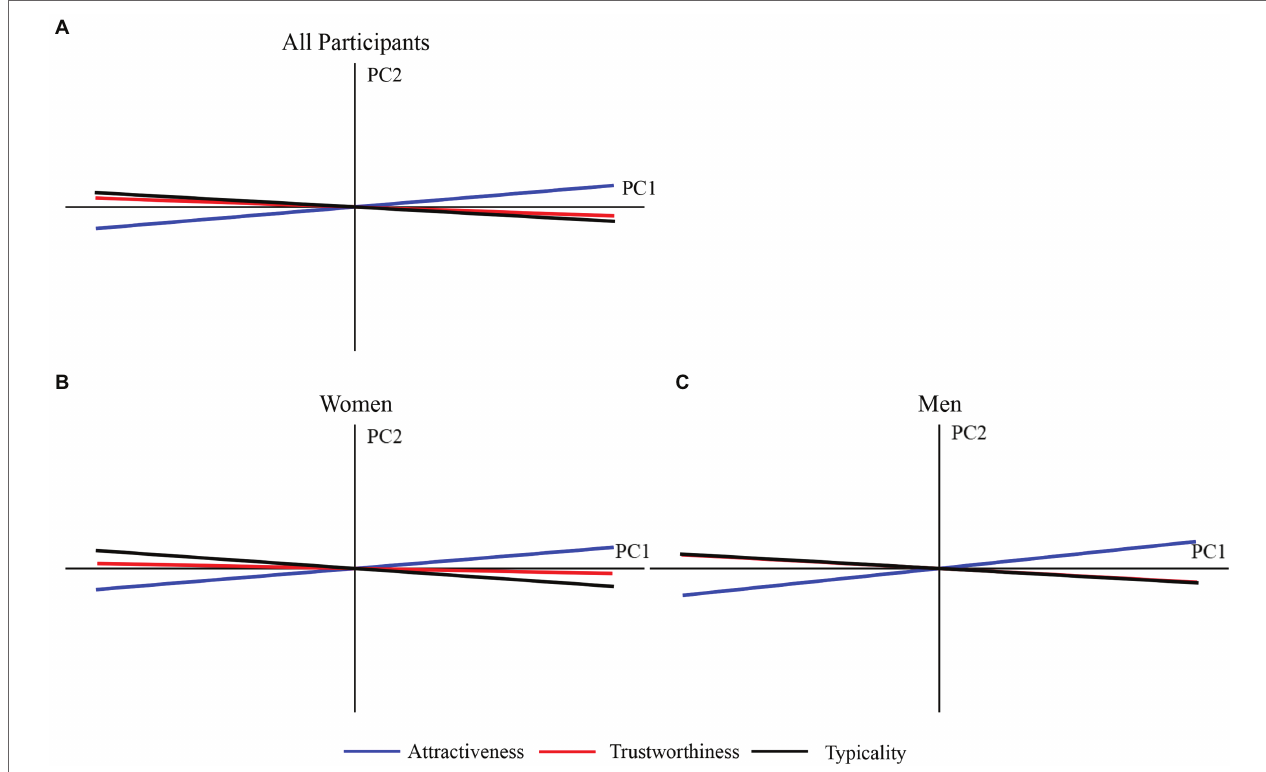
FIGURE 6 | Principal component analyses of trait judgments across (A) all participants, (B) women only, and (C) men only. Space was built based on first two principal components (PCs; first PC: x-axis; second PC: y-axis). Locations of trait judgments are represented by their correlations with axes.